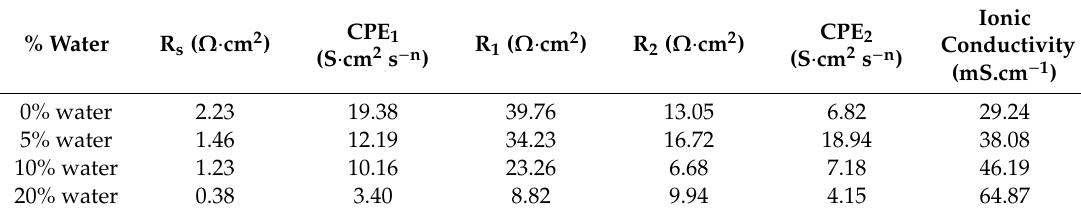
Table 2. Results of EIS studies of Al in 3 M KOH methanol solutions containing di ff erent ratios of water (0%, 5%, 10%, and 20% (v / v)) and ionic conductivity of the methanol